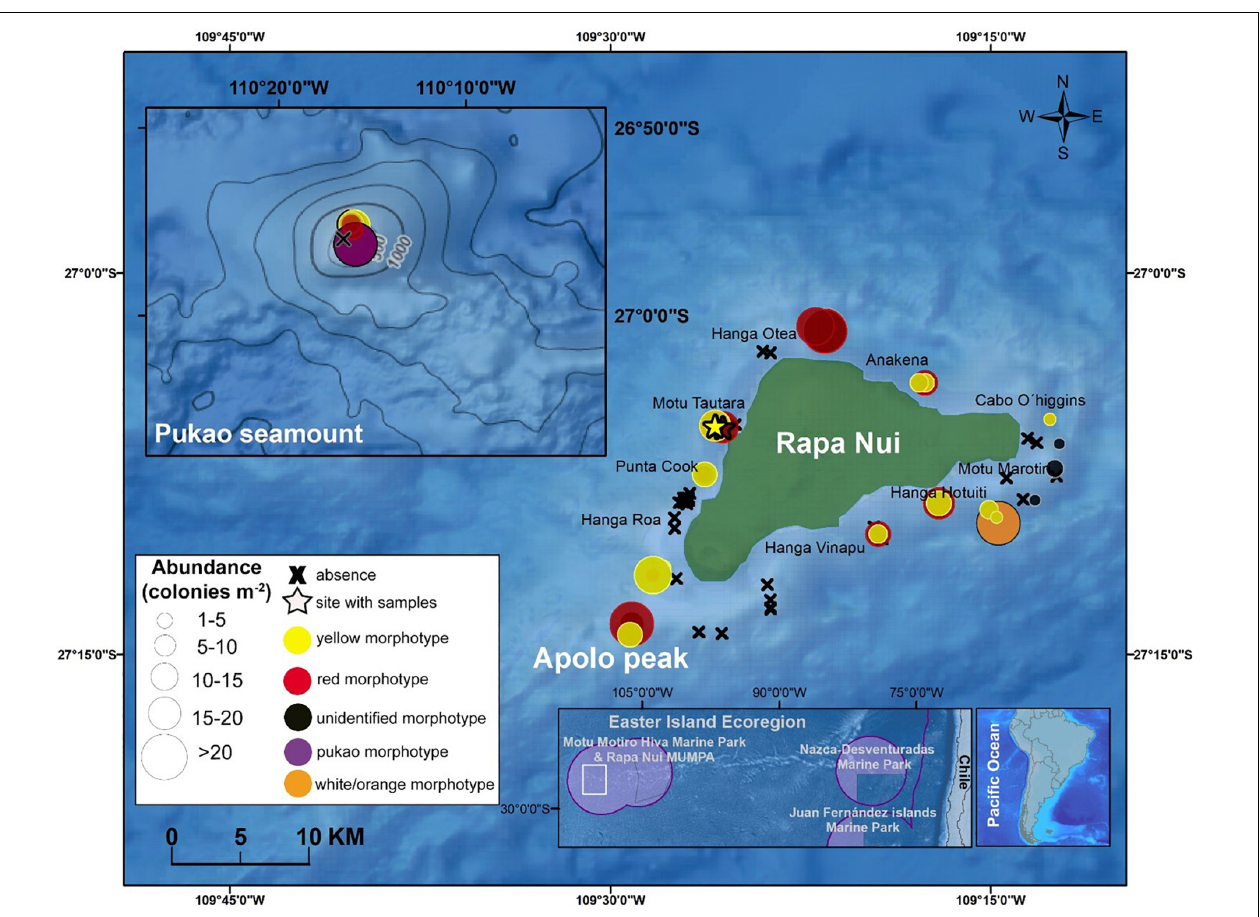
FIGURE 1 | Whip black coral abundance and ROV survey locations (2014–2019) on the Apolo peak, the summit of Pukao seamount, and around Rapa Nui (Easter Island) at 50–330 m. X = absence of whip corals, stars = stations where specimens were collected, purple line = Chilean Economic Exclusive Zone, pink area = Chilean Marine Parks. Map generated using ArcMap (version 10.8) and GEBCO and NCEI base maps (British Oceanographic Data Centre, 2008; NCEI, 2021). Note that when multiple morphotypes were recorded during a survey, points overlap.